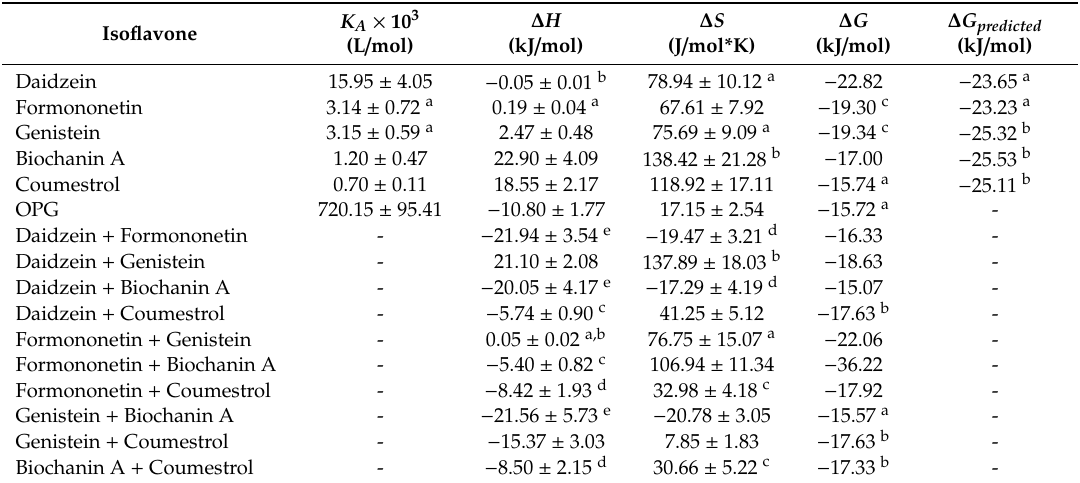
Table 1. Thermodynamic parameters of interactions of isoflavones with RANKL determined by isothermal titration calorimetry (ITC) and docking simulation (∆ G predicted ).